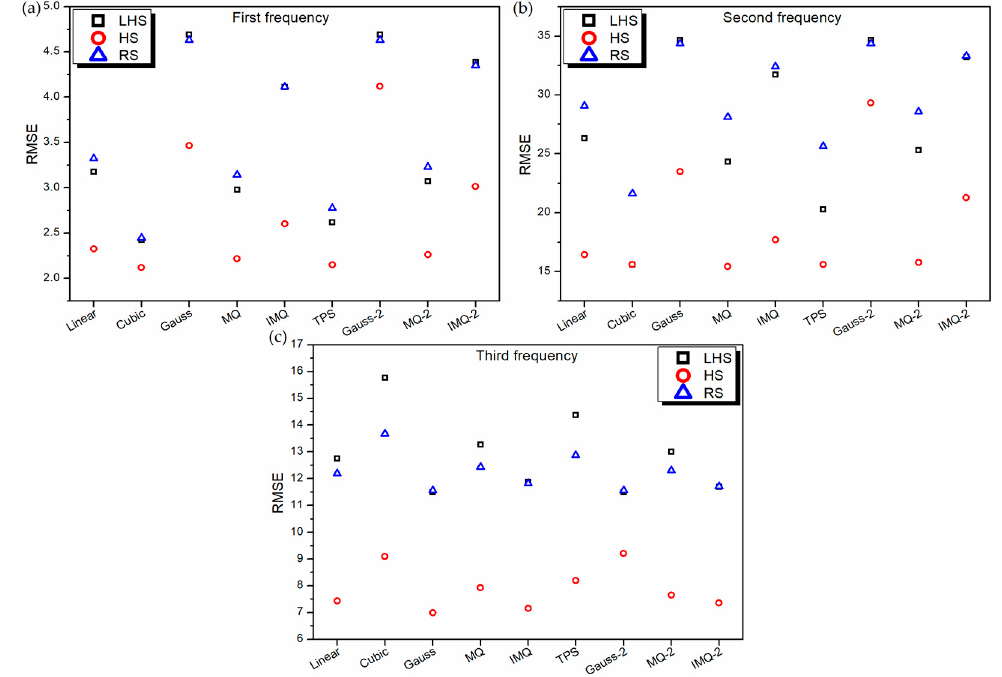
Figure 12. RMSE of various RBF metamodels in HD problem for testing data.